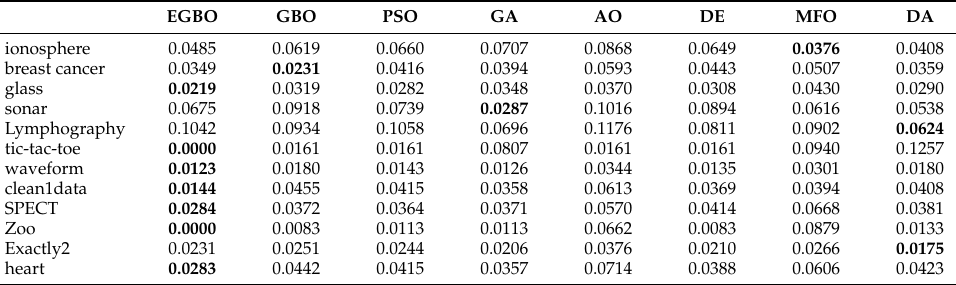
Figure 4. Average of the fitness function values for all methods. Table 9. Results of the standard